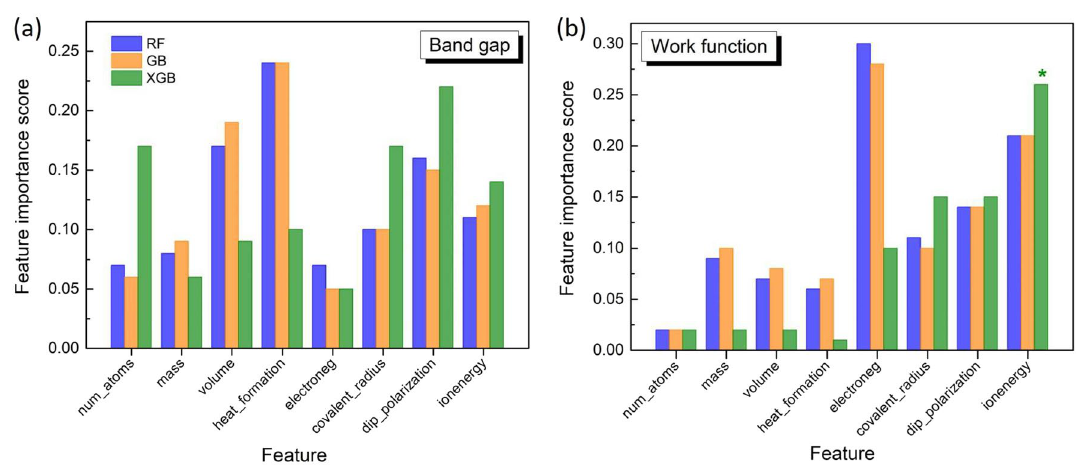
Figure 6. Feature importance scores of the input features for RF, GB, XGB models. The scores obtained from the bandgap prediction ( a ) and the work-function prediction ( b ). In ( b ) the asterisk (*) means that the magnitude of “ionenergy” for XGB model was divided by